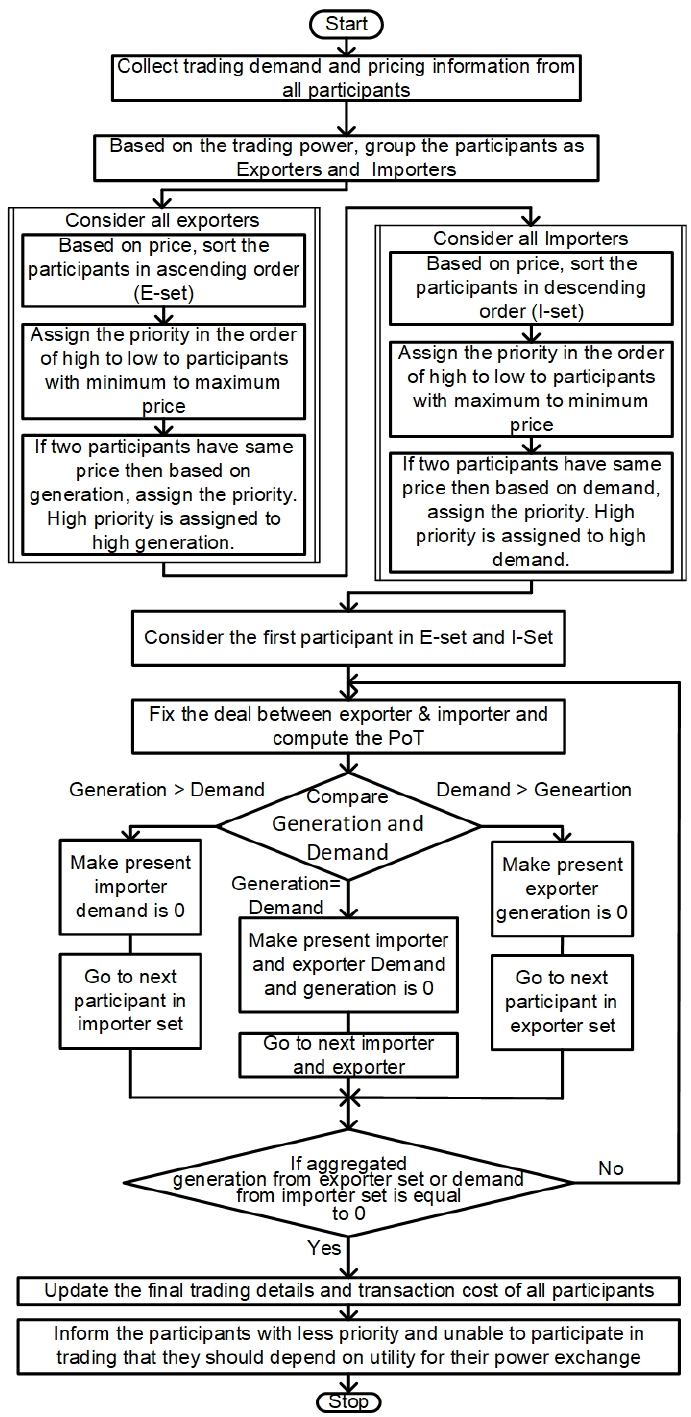
Figure 5. TEMO market-clearing mechanism flowchart using PAS.